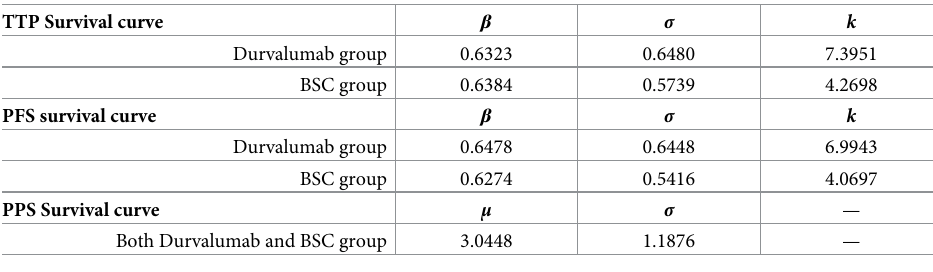
Table 1. Parameters of survival